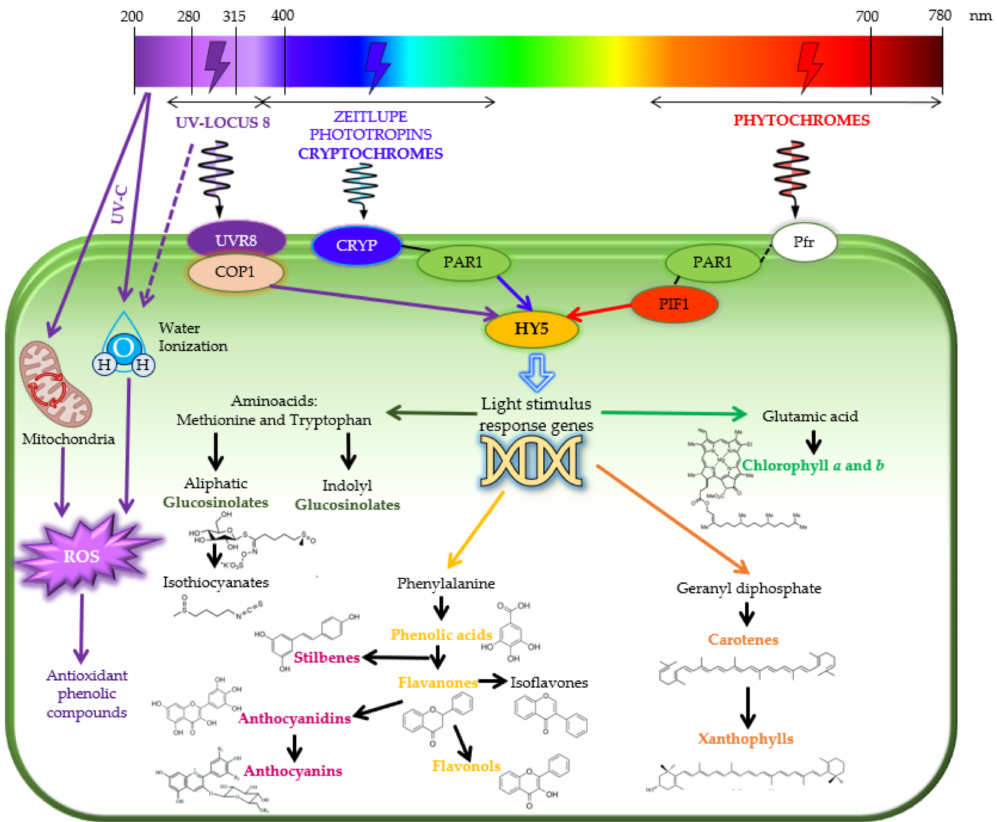
Figure 3. Effect of different wavelengths on plant secondary metabolism: phytochemical accumu- lation due to photoreceptors and UV-C induced ROS (reactive oxygen species) production. UVR8: UV RESISTANCE LOCUS 8; COP1: COP1 E3 Ubiquitin Ligase; CRYP: cryptochromes; PAR1: t Protease-activated receptor-1; HY5: elongated hypocotyl-5; PIF1: phytochrome-interacting factor-1; Pfr: